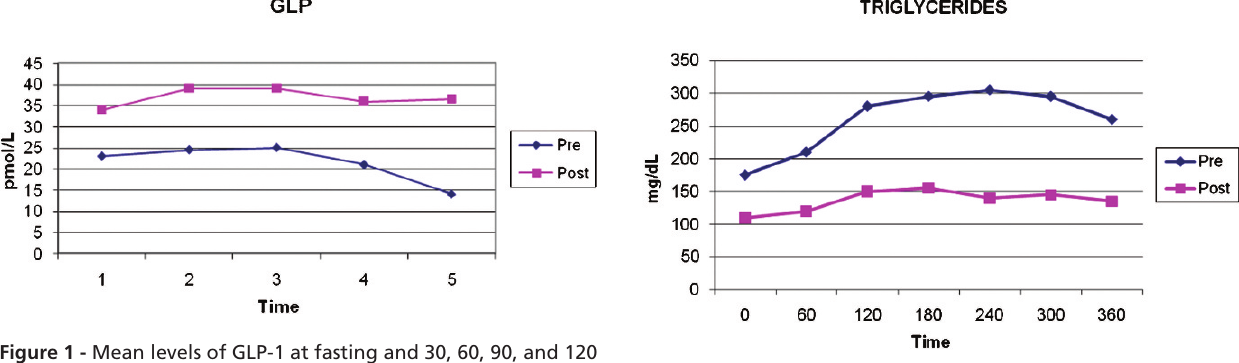
Figure 3 - Mean levels of triglycerides (mg/dL) at fasting and 60, 120, 180, 240, 300, and 360 minutes after a standard meal, pre- and postoperatively. *